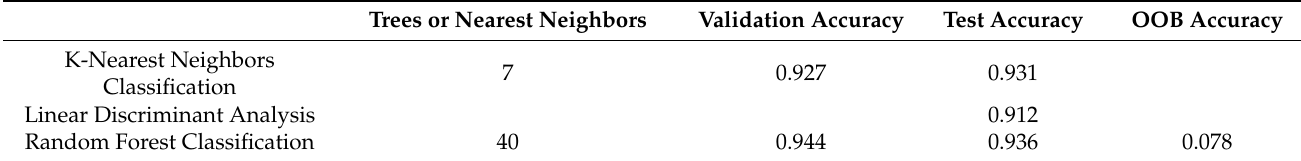
Table 2. Accuracy in each predictive model.